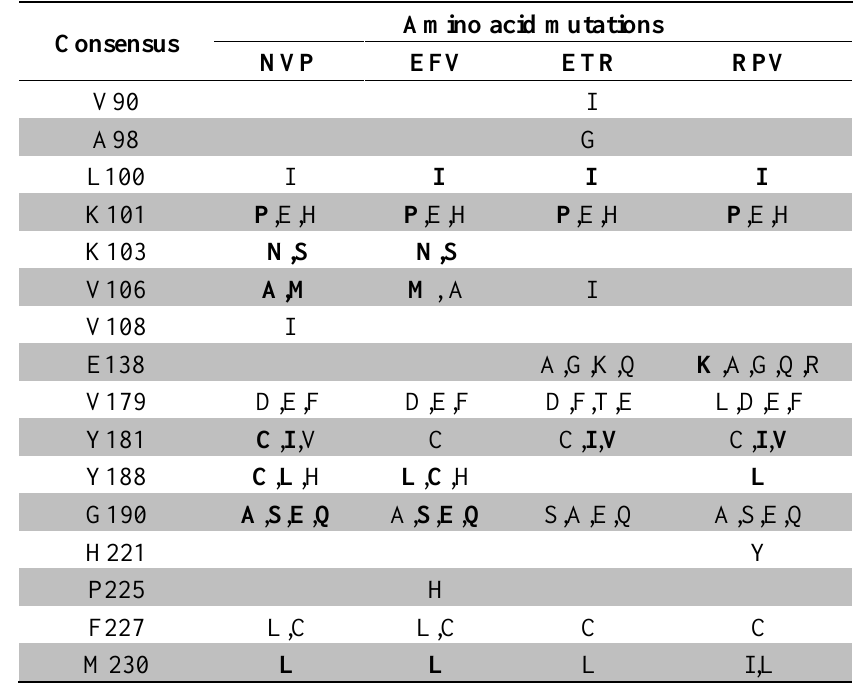
Table 3. Major NNRTI Resistance